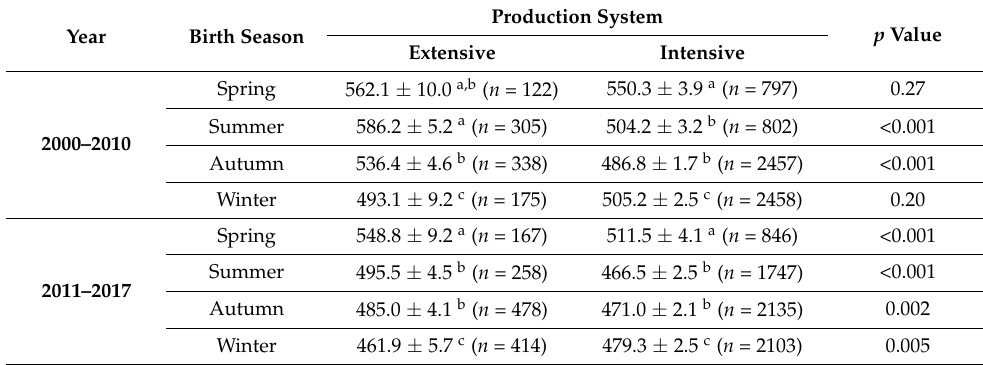
a,b,c superscript letters within columns and for the same year period: p <